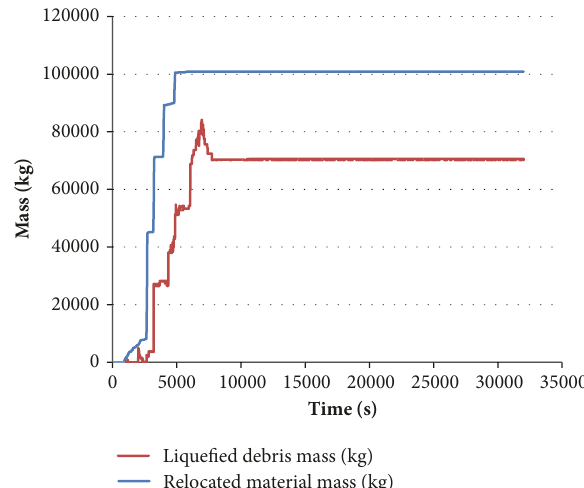
Figure 13: Maximum RPV internal wall temperature for each